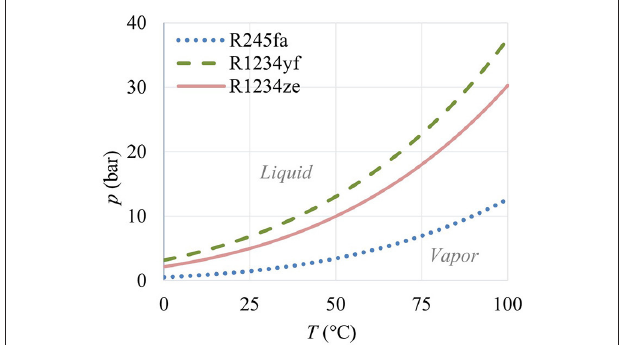
FIGURE 2 | Liquid vapor pressure for used working fluids.